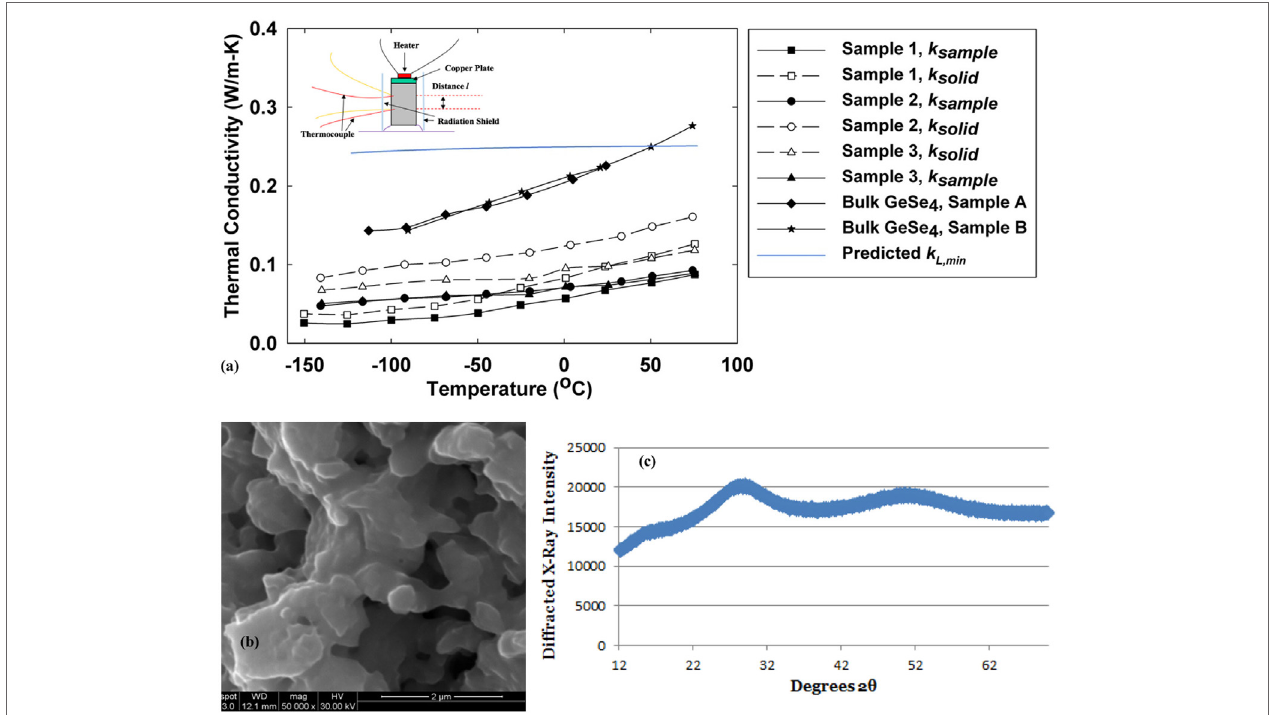
FIGurE 1 | (A) Temperature-dependent k values of GeSe 4 glass and nanograined bulk GeSe 4 glass. The inset is experimental setup. Solid symbols connected by solid lines are the measurement results, whereas empty symbols with dashed lines indicate the nanoporous k solid for nanograined bulk samples. The symbols used for nanograined bulk samples are square (Sample 1), triangle (Sample 2), and circle (Sample 3); (B) scanning electron microscopy image of Sample 1, with the scale bar as 2 µm; and (C) the X-ray diffraction pattern of representative sample